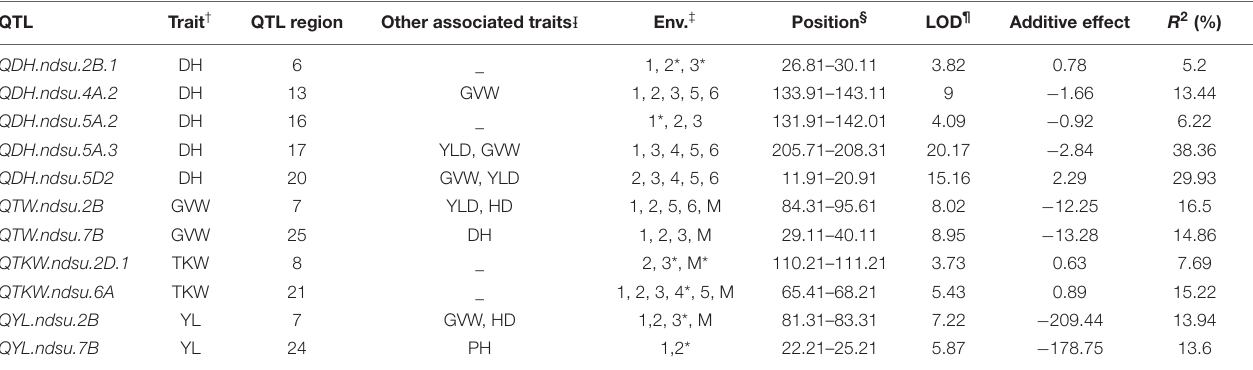
TABLE 2 | Quantitative trait loci for drought tolerance in an RIL population derived from the cross between Reeder and Albany. QTL Trait † QTL region Other associated traits - I